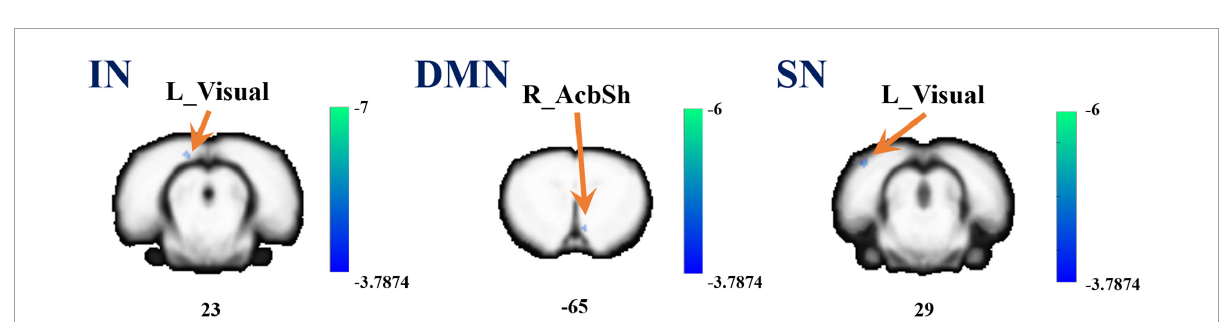
FIGURE4 A brain with altered function within the network between the sham and MCAO/R groups. Altered functional activity in the interoceptive network (IN), default mode network (DMN), and salience network (SN). Warm colors denote higher functional activity in the MCAO/R group compared with the sham group, and cool colors denote lower functional activity in the MCAO/R group. Two sample t -test ( P = 0.001, alphasim corrected, cluster size > 10).